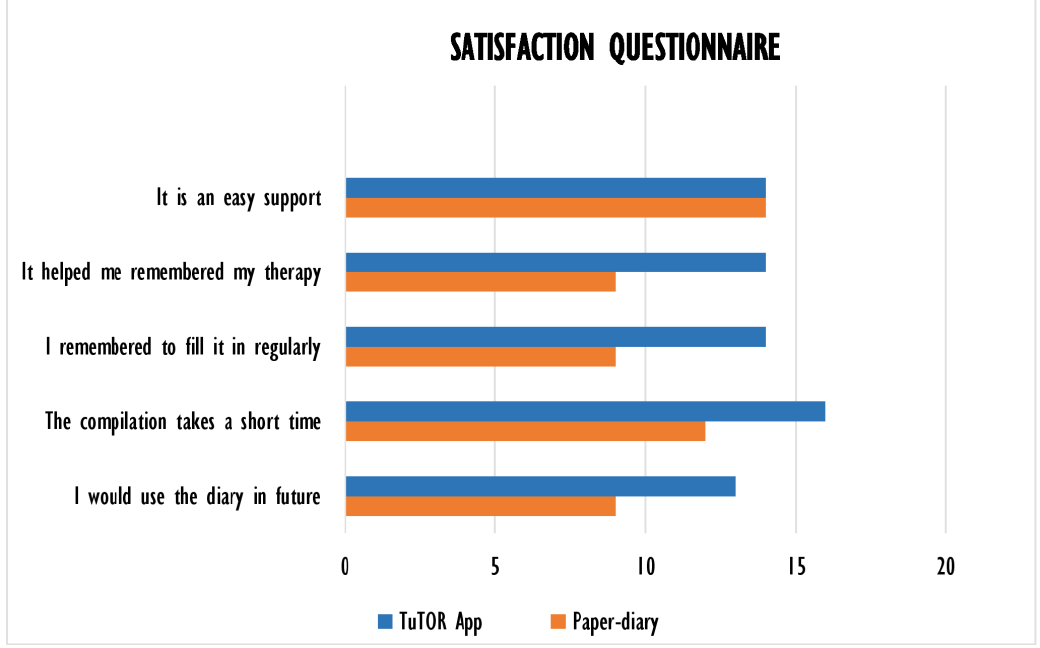
Figure 6. Graphical representation of the results of the satisfaction questionnaires filled out at the end of the study by the enrolled patients.